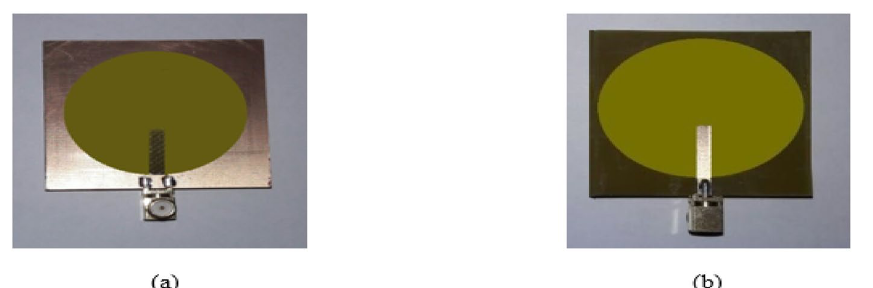
Figure 23. Manufactured prototype of Antenna1 ( a ) ground plane, ( b ) microstrip feed plane.